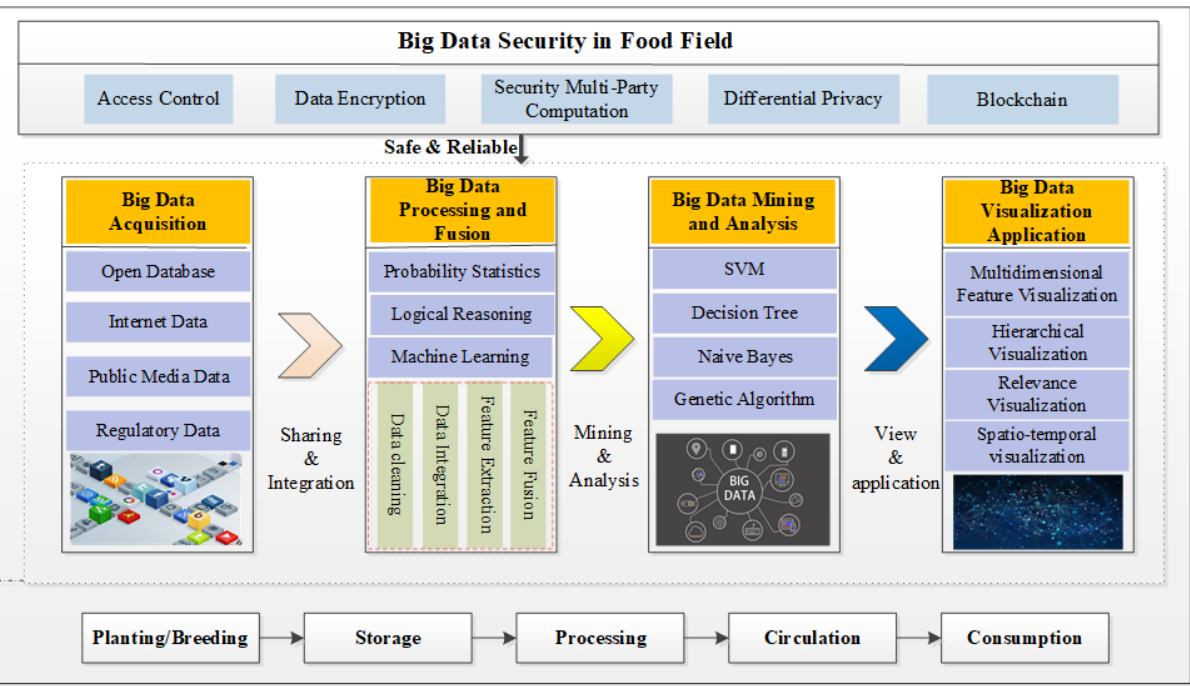
Figure 3. The processing model of big data in